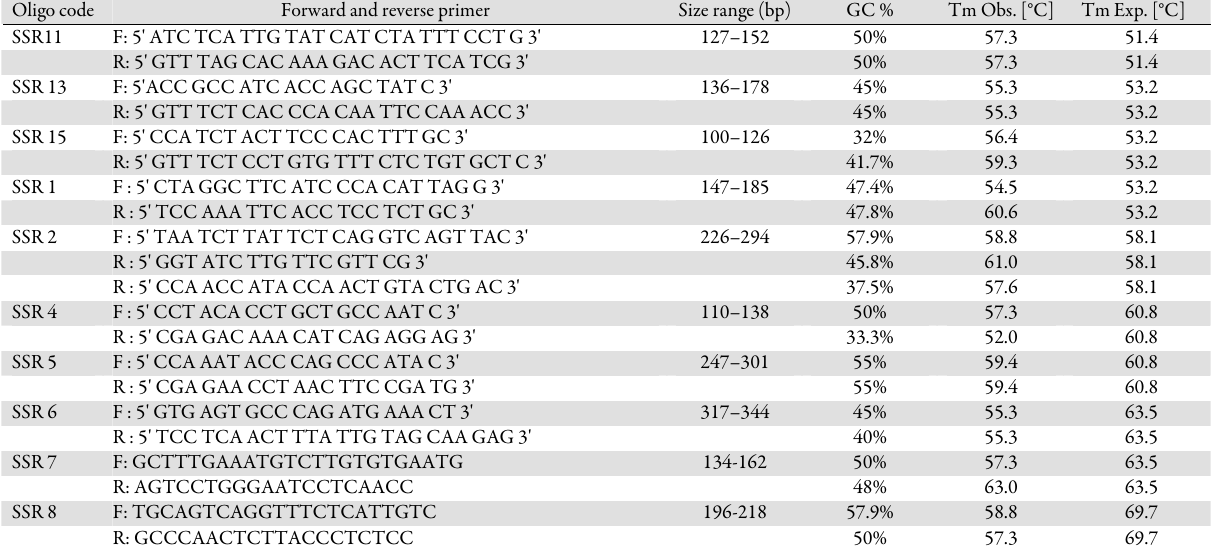
Table 2. SSR primer pairs used for Opuntia ficus-indica DNA amplification